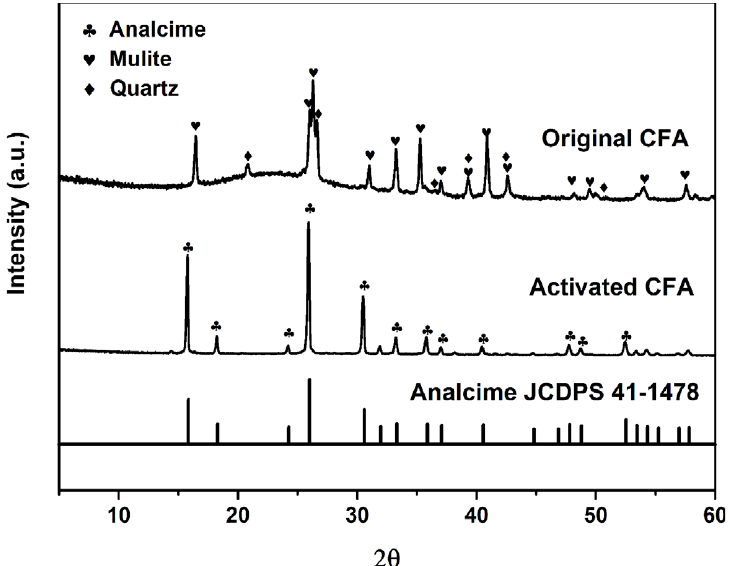
Figure 2. Wide-angle XRD patterns of CFA before and after the subcritical hydrothermal activation treatment.